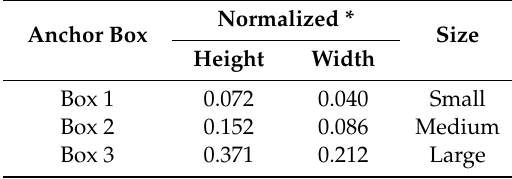
Table 7. Size of the three selected anchor boxes (* The ranges of normalized height and width are from 0 to 1,